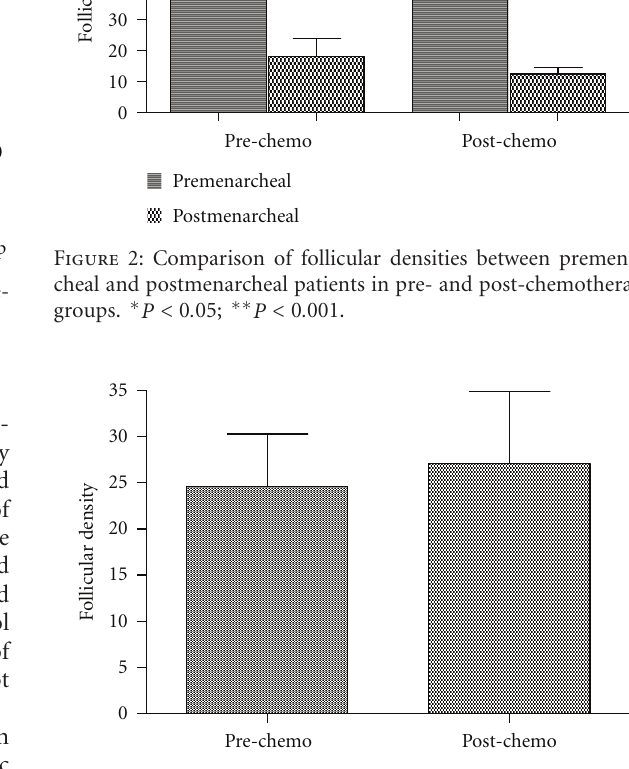
Figure 3: Comparison of follicular densities between pre- chemotherapy and post-chemotherapy groups. The di ff erence is not